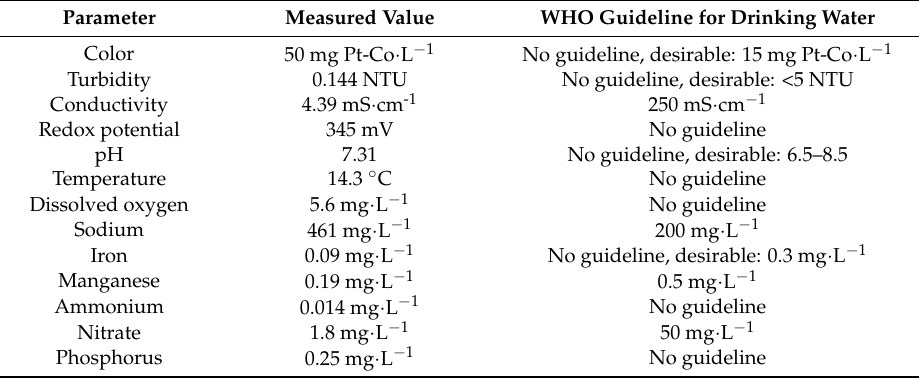
Table 1. Characteristics of the pre-treated groundwater used during the experiment compared with the health-based drinking water guidelines of the World Health Organization (WHO) [5]. Parameter Measured